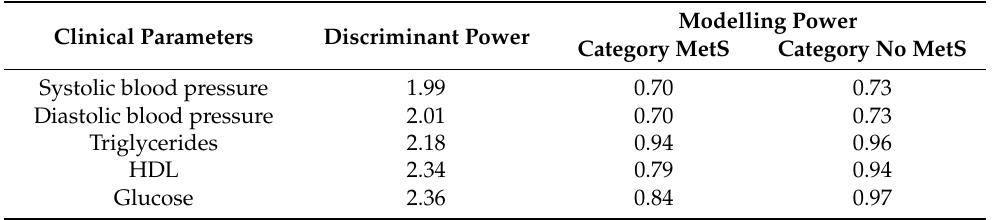
Table 4. The values of discriminant and modelling powers of clinical parameters after SIMCA